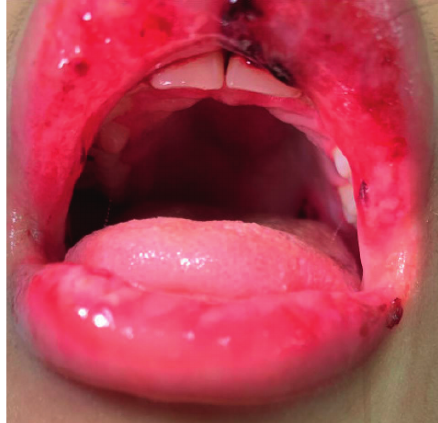
Figure 2: Oral ulcer on the left posterior palate at the time of